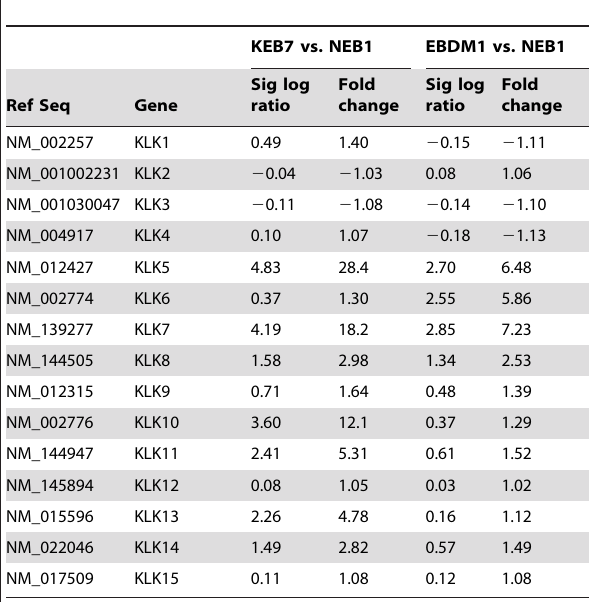
KEB7 vs. NEB1 EBDM1 vs.